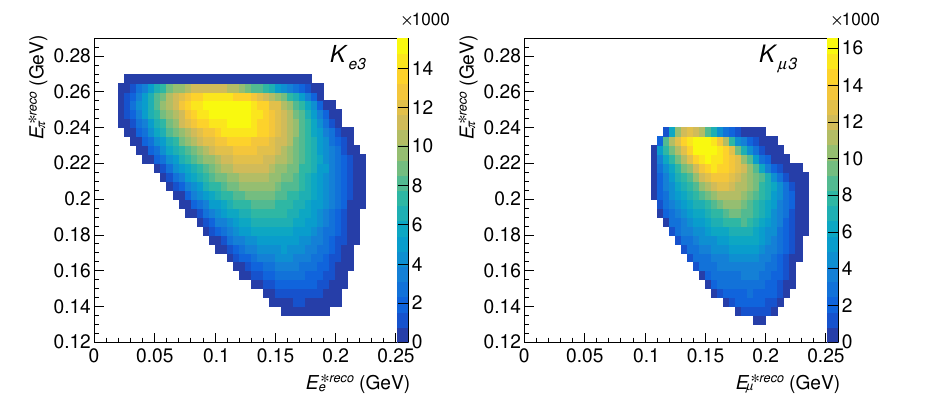
Figure 6. Dalitz plot distributions after the full selection of reconstructed K ± selection, right: K ± selection. µ 3